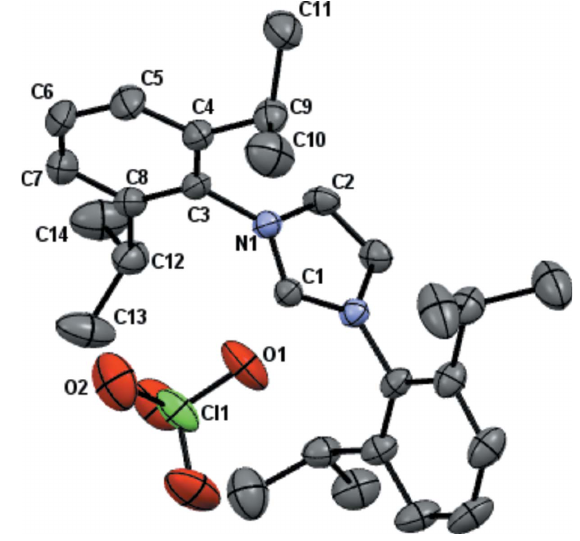
Figure 1 The molecular structure of the title compound with displacement ellipsoids at the 50% probability level. H atoms are omitted for clarity and unlabelled atoms are generated by the symmetry operator ( (cid:3) x + 3 (cid:3) y + 1 , z 2